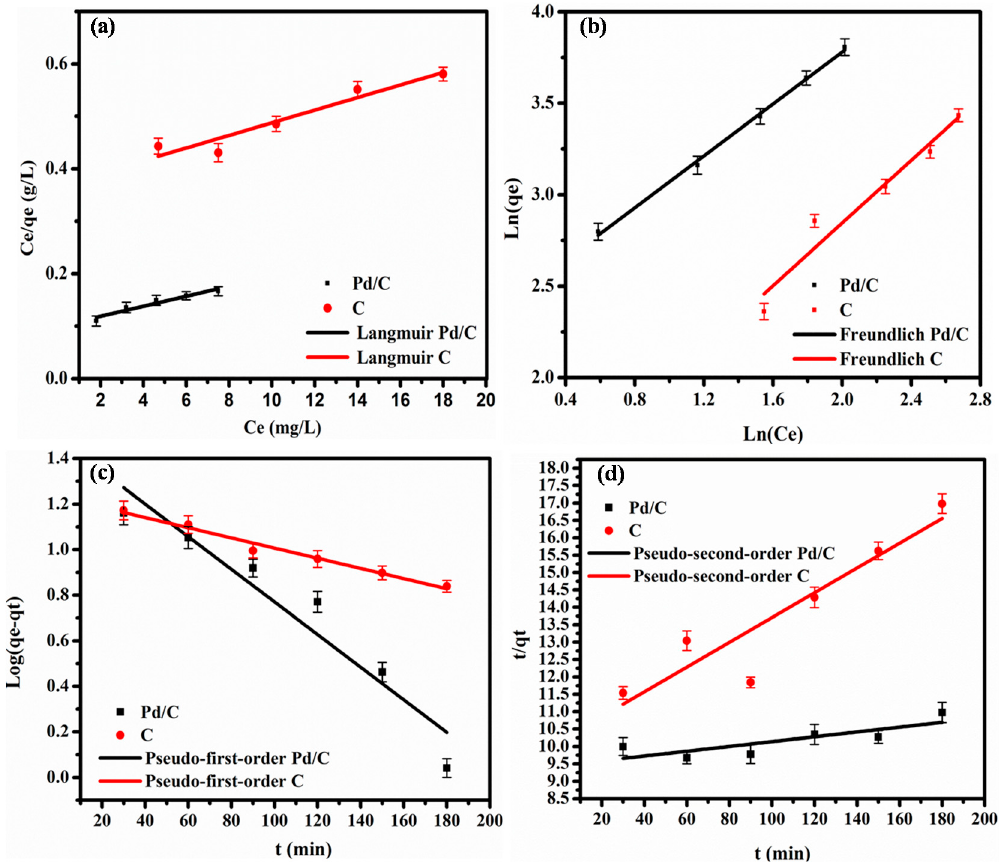
Figure 6. Linear Langmuir model ( a ) and linear Freundlich model ( b ) for MO dye adsorption onto Pd/CNF and CNF samples after 3 h. The curves show the linear fitting of the experimental data. Linear fitting of the kinetic results using the pseudo-first-order ( c ) and pseudo-second-order ( d ) models during 3 h.